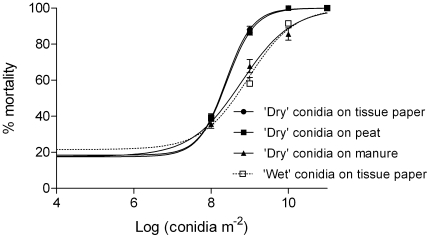
Effect of substrates on fungus dose.Mean (± SEM) mortality of adult Culiocides nubeculosus 3–4 days of age, 6 days post exposure to different doses (108–1011 conidia m−2) of ‘dry’ and ‘wet’ conidia of Metarhizium anisopliae V275 on separate substrates at 20±1°C. Controls were not exposed to any fungus (‘0’ doses). The sigmoidal models were fitted to the data using nonlinear regression. Data represent survival of eight replicates of approximately 40 adult males and females/replicate.